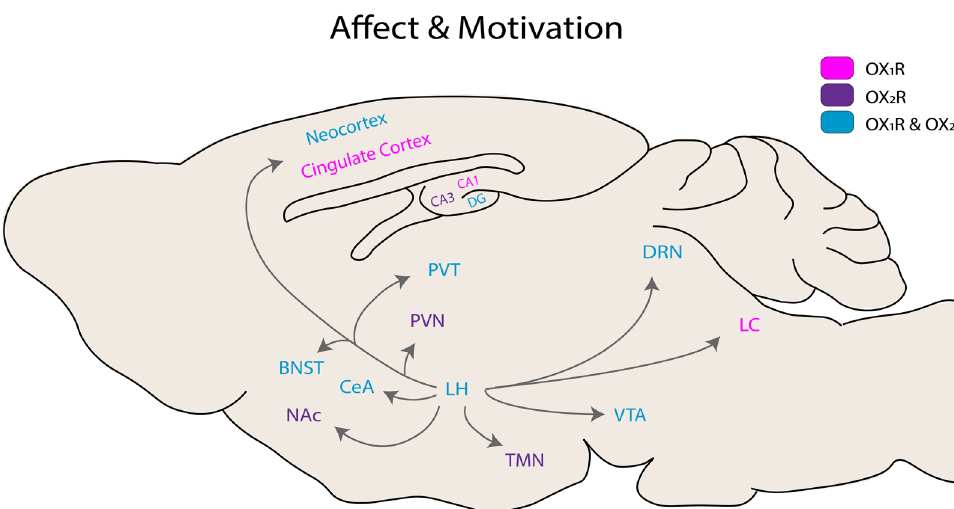
Figure 2. Hypocretin receptor distribution in the rodent brain. BNST, bed nucleus of the stria terminalis; CeA, central amygdala; DG, dentate gyrus; DRN, dorsal raphe nucleus; LC, locus coeruleus; LH, lateral hypothalamus; NAc, nucleus accumbens; PVN, paraventricular nucleus; PVT, paraventricular nucleus of the thalamus; TMN, tuberomammillary nucleus; VTA, ventral tegmental